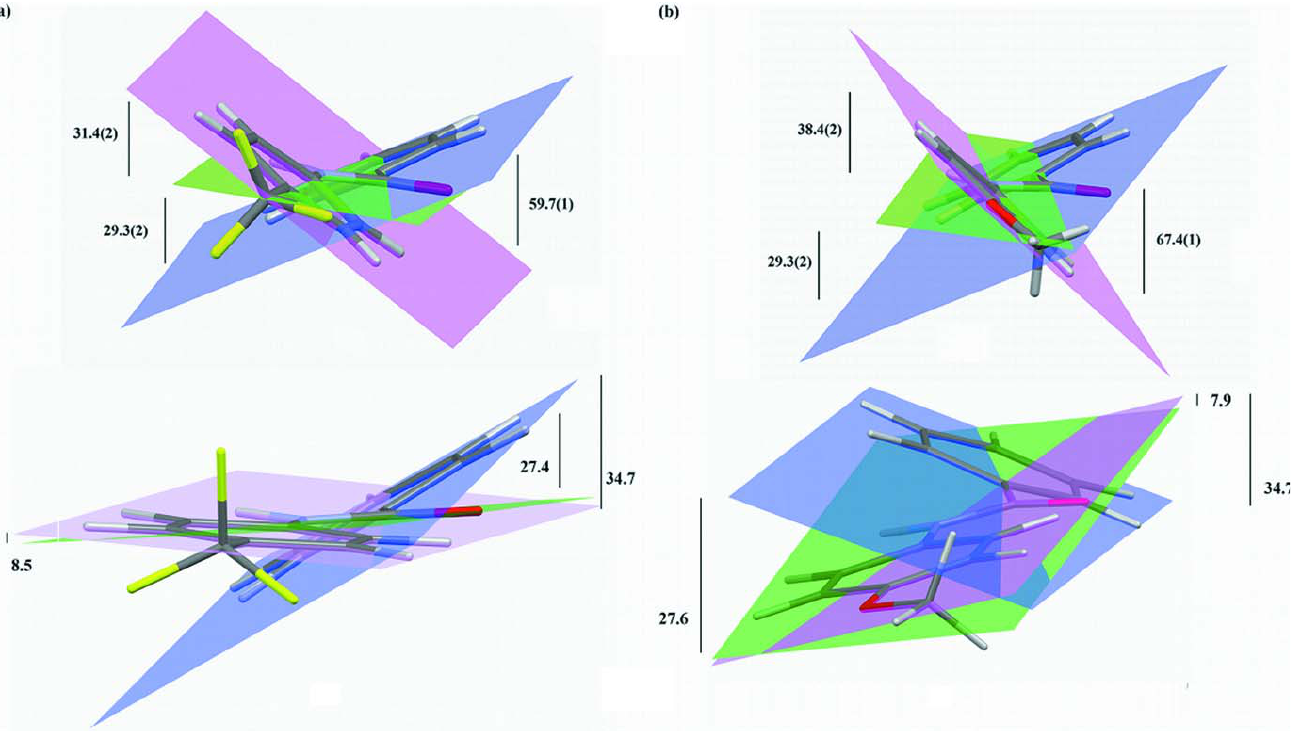
Figure 3 Views of orientations of planar regions and their dihedral angles (in (cid:2) ) from experimental results (top) and DFT calculations (bottom) for ( a ) TFMP and ( b ) MOP . Blue = phenyl ring; green = amide plane; mauve = para -substituted phenyl